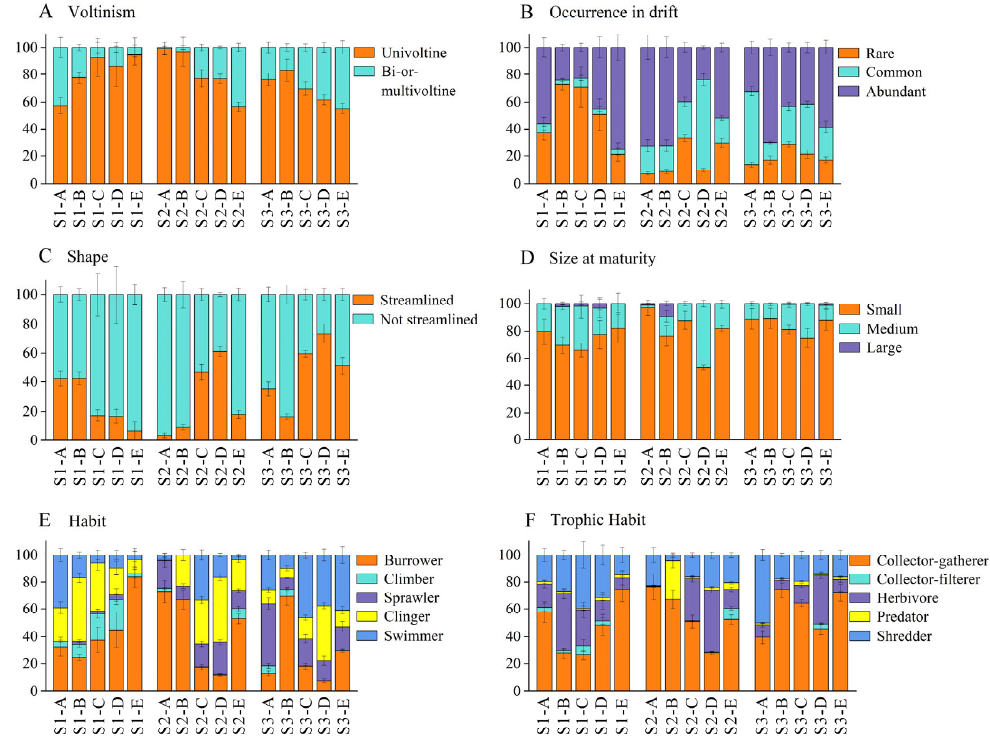
Figure 3. Average percentage ( ± SD) of a given trait category: voltinism ( A ); occurrence in drift ( B ); shape ( C ); size at maturity ( D ); habit ( E ), and trophic habit ( F ) of S1, S2, and S3. S1: Grazing stream; S2: Hot spring stream; S3: Mining stream.